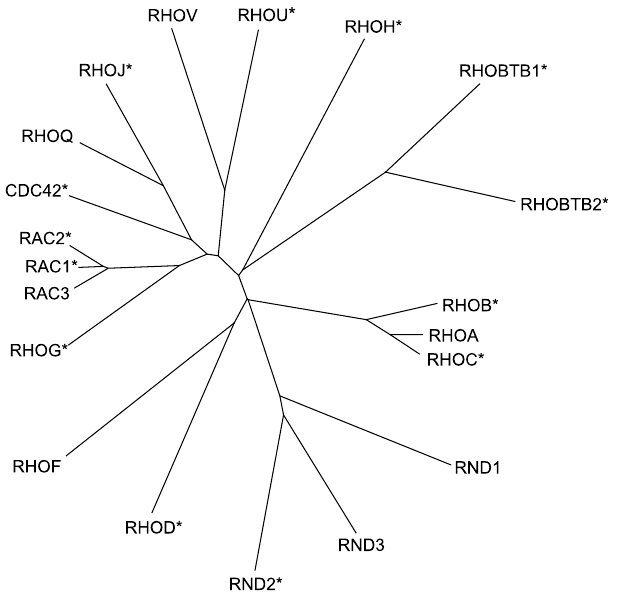
Figure 1. Twenty human Rho GTPase family members. A ClustlW alignment using the amino acid sequences of the 20 human Rho GTPases was used to generate the phylogenetic tree. *, 14 genes able to be analysed by MR (see Table